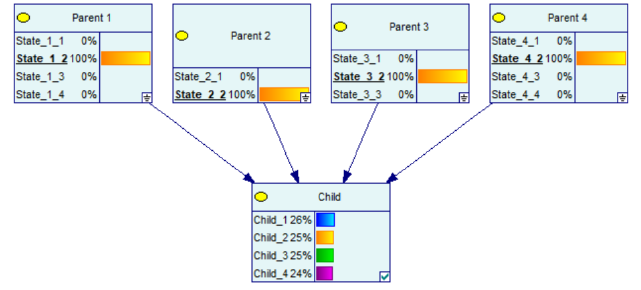
Figure 8. Hassall’s algorithm: example to show the order of the parent’s states.